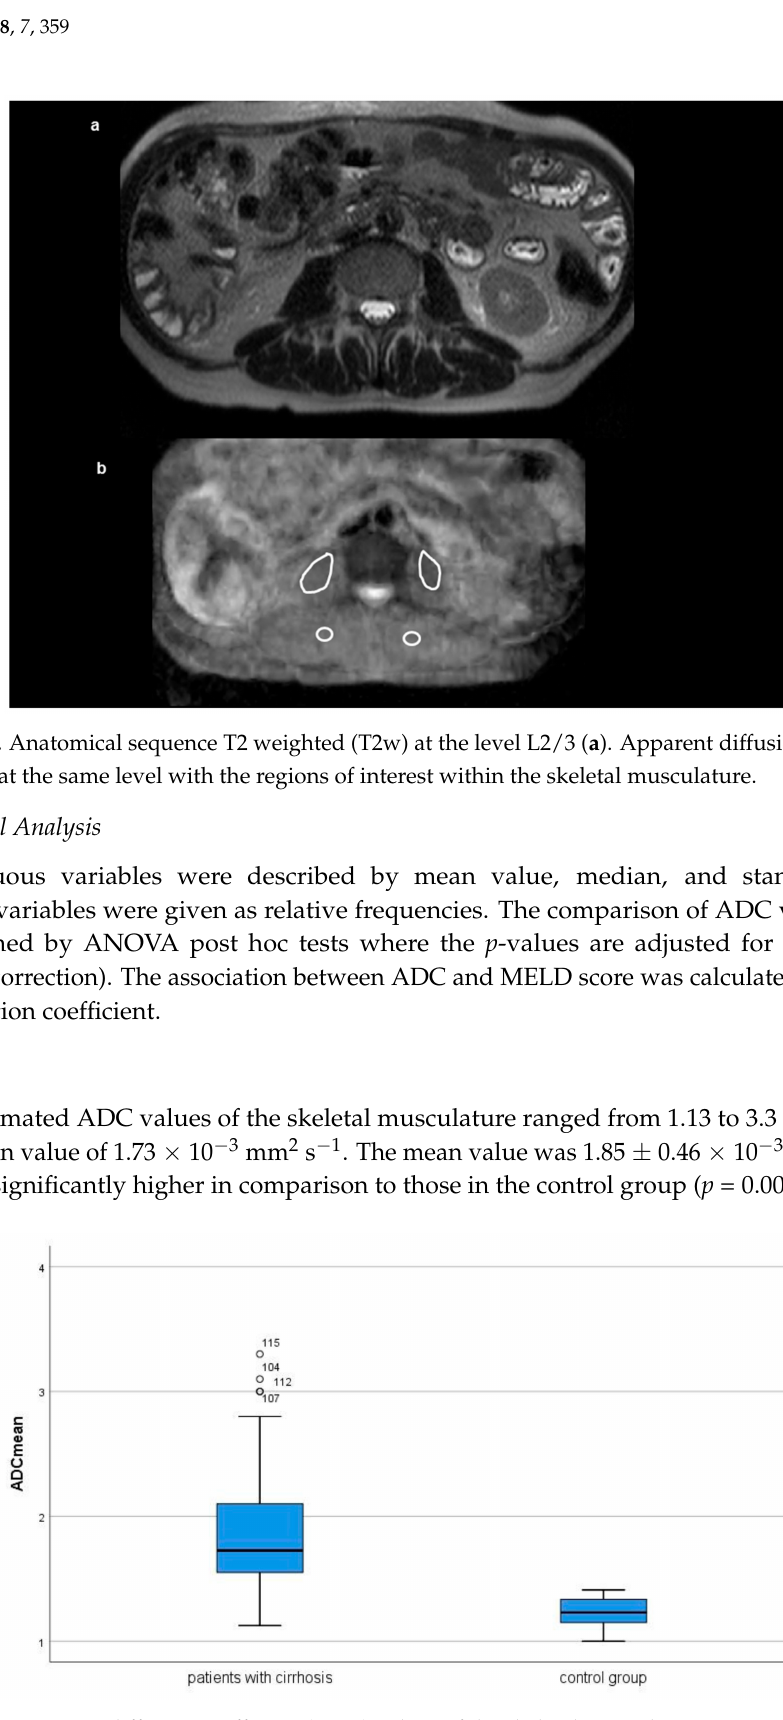
Figure 3. Apparent diffusion coefficient (ADC) values of the skeletal musculature in patients with liver cirrhosis and control group. Patients with liver cirrhosis show higher ADC values in comparison to the control group (1.85 ± 0.46 × 10 − 3 mm 2 s − 1 vs. 1.23 ± 0.12 × 10 − 3 mm 2 s − 1 , p =